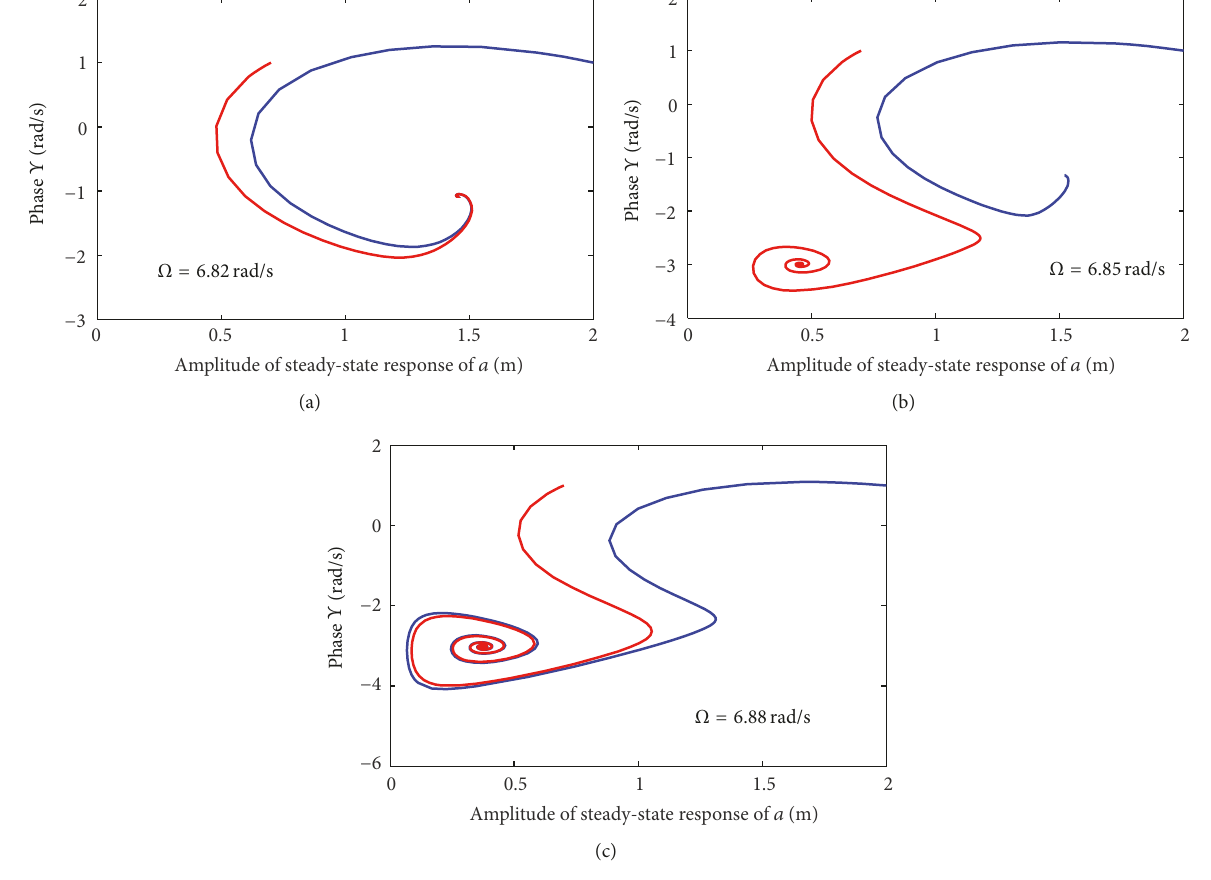
Figure 14: Different solution induced by Hopf